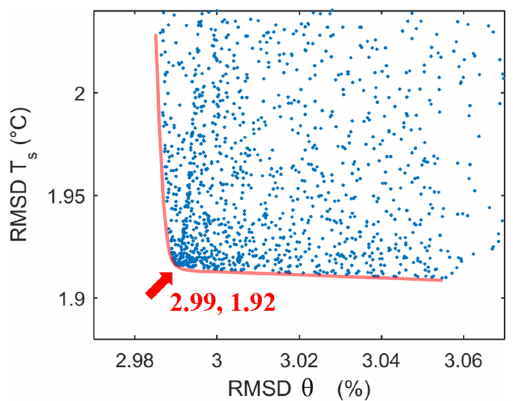
Figure 5. Objective function values of the evaluated parameter sets and the corresponding Pareto front. The x axis is the objec- tive function for simulating θ ; the y axis is the objective function for simulating T s . Each dot corresponds to one simulation perfor- mance. Each of the simulations represents a different combina- tion of candidate parameter sets. The dot closest to the red arrow was chosen to be the optimal parameter set for the SVEN con- tinuous simulation. C sat , b , C veg , and SWS max at the Pareto-front point are 6 . 94 × 10 − 6 Km 2 J − 1 , 5.20, 2 . 18 × 10 − 6 Km 2 J − 1 , and 5 . 54 × 10 − 1 m